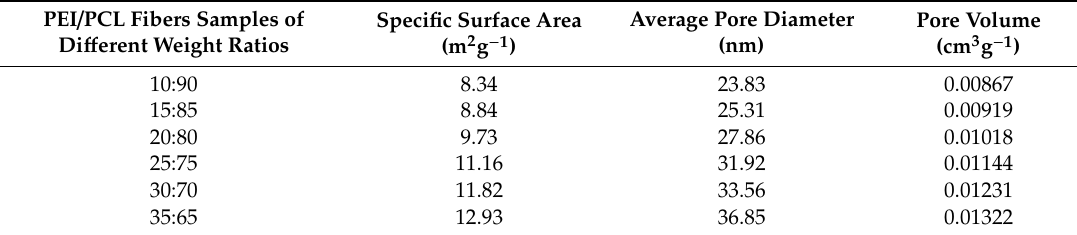
Table 1. Physical data of as-prepared different fiber composites.